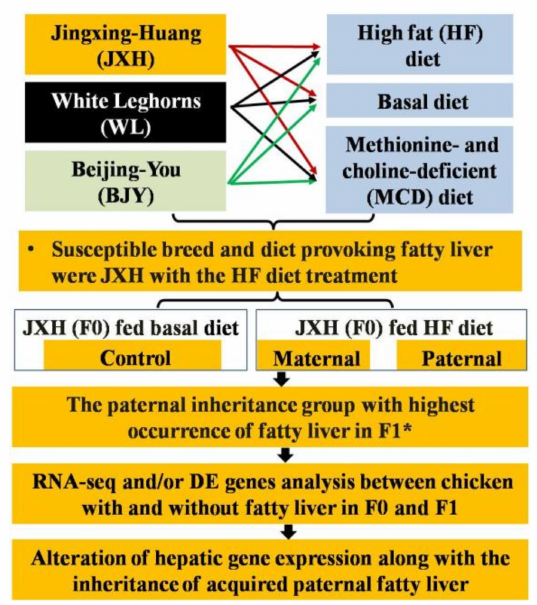
Figure 1. Graphic representation of the experimental procedures and main results. * The F1 chickens of control, maternal and paternal groups were all fed normal diet. DE: differentially